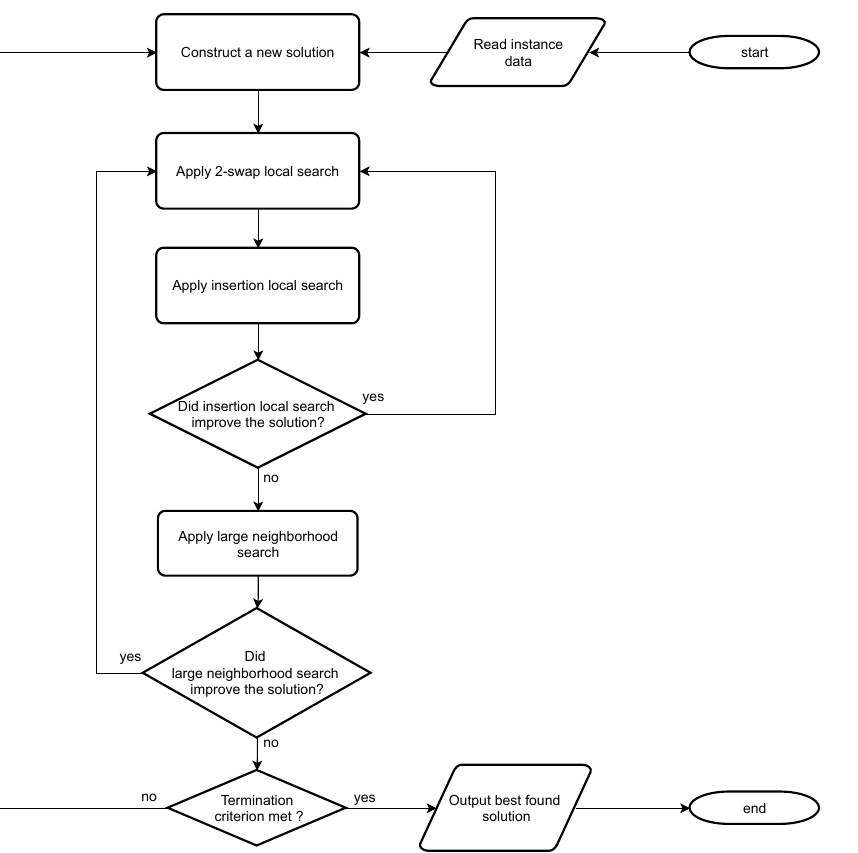
Figure 3. The c-type pseudocode of the Refining Decomposition-based Integrated Search (RDIS) algorithm.